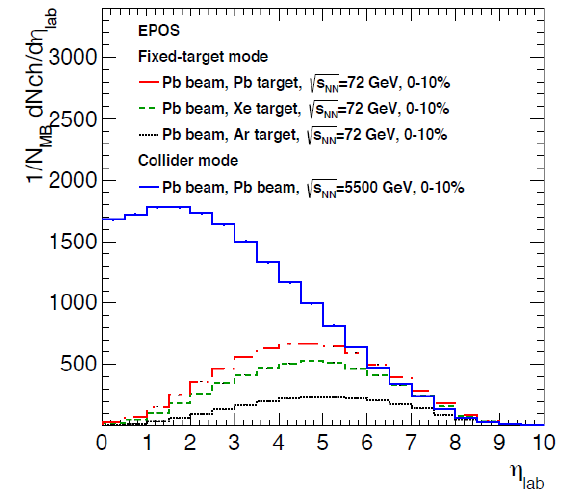
Figure 1. Averaged charged particle multiplicity as a function of the pseudo-rapidity in the laboratory frame for various heavy-ion